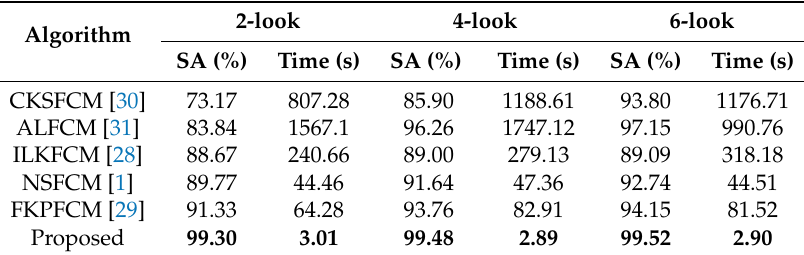
Table 3. Experimental results on SI3 simulated